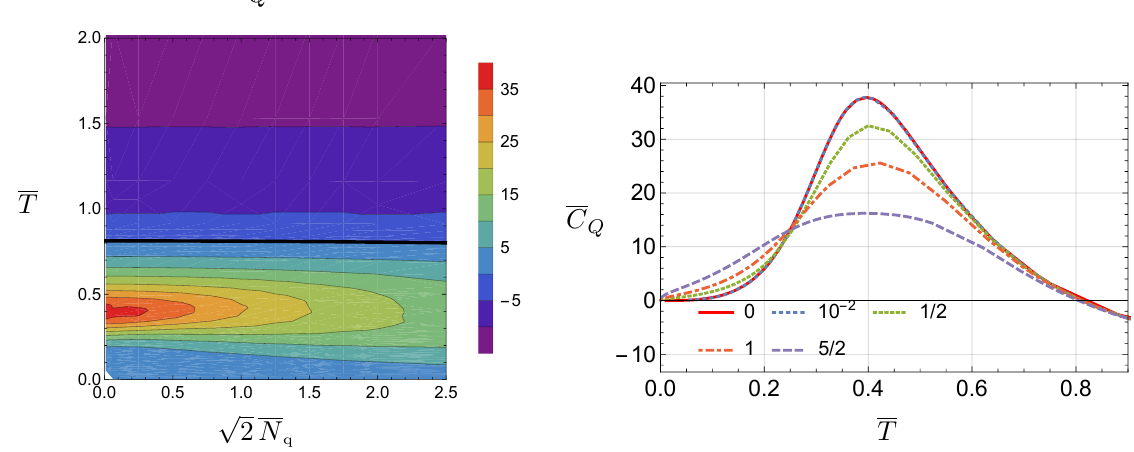
Figure 14. (Left) Contour plot of the dimensionless speci(cid:12)c heat (4.25) . The thick, approximately horizontal black curve indicates the locus where C Q = 0. (Right) Dimensionless speci(cid:12)c heat as a function of temperature for several (cid:12)xed values of the charge density